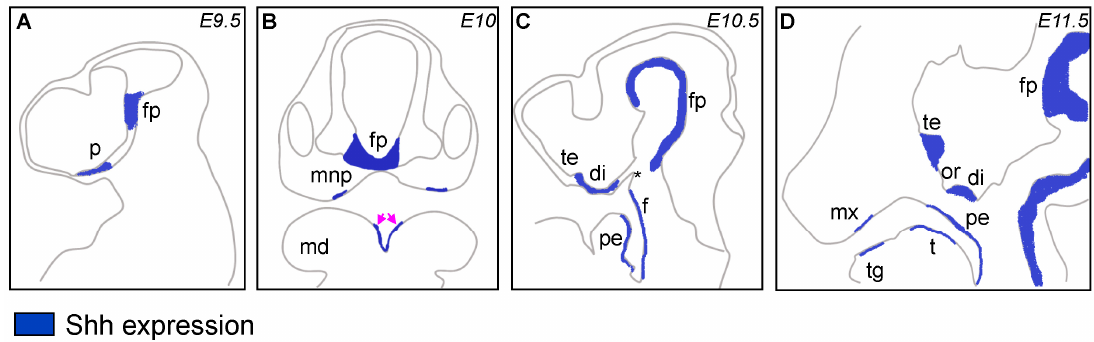
Figure 3. Expression of Shh in the developing (mouse) craniofacial skeleton. At E9.5 ( A ), Shh is expressed in the ventral-most region of the neural tube, the floor plate (fp) as well as in the ventral prosencephalon (p). At E10, expression within the fp becomes more abundant, and expression is also seen within isolated regions of the medial nasal processes (mnp) as well as the developing mandibular (md) periderm (arrows; B ). By E10.5 ( C ), Shh is localized to the ventral diencephalon (di) and telencephalon (te), as well as in the foregut (f) and pharyngeal endoderm (pe), with notable exclusion from the ectodermal swelling of Rathke’s pouch (asterisk); At E11.5 ( D ), the expression domain of the floor plate extends caudally along the entire length of the neural tube. Expression is maintained within the diencephalon and telencephalon, separated by an exclusion zone at the optic recess (or). Expression is also visible in the epithelium lining the tongue (t), within tooth germs (tg) along the length of both the maxilla and mandible, as well as within the leading edge of the maxillary palatal shelves (mx). Panels A , C and D are sagittal, Panel B is coronal. Adapted from [8].